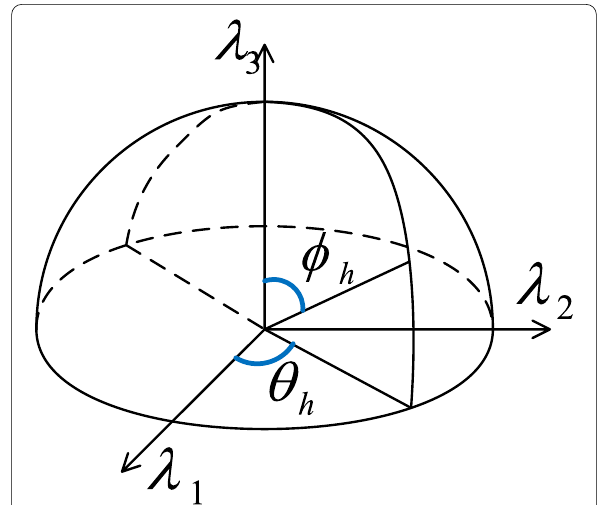
Fig. 4 Diagram showing the azimuth and polar angles θ h and φ h respectively from a eigenvalue vector H = ( (cid:31) 1 , (cid:31) 2 , (cid:31) 3